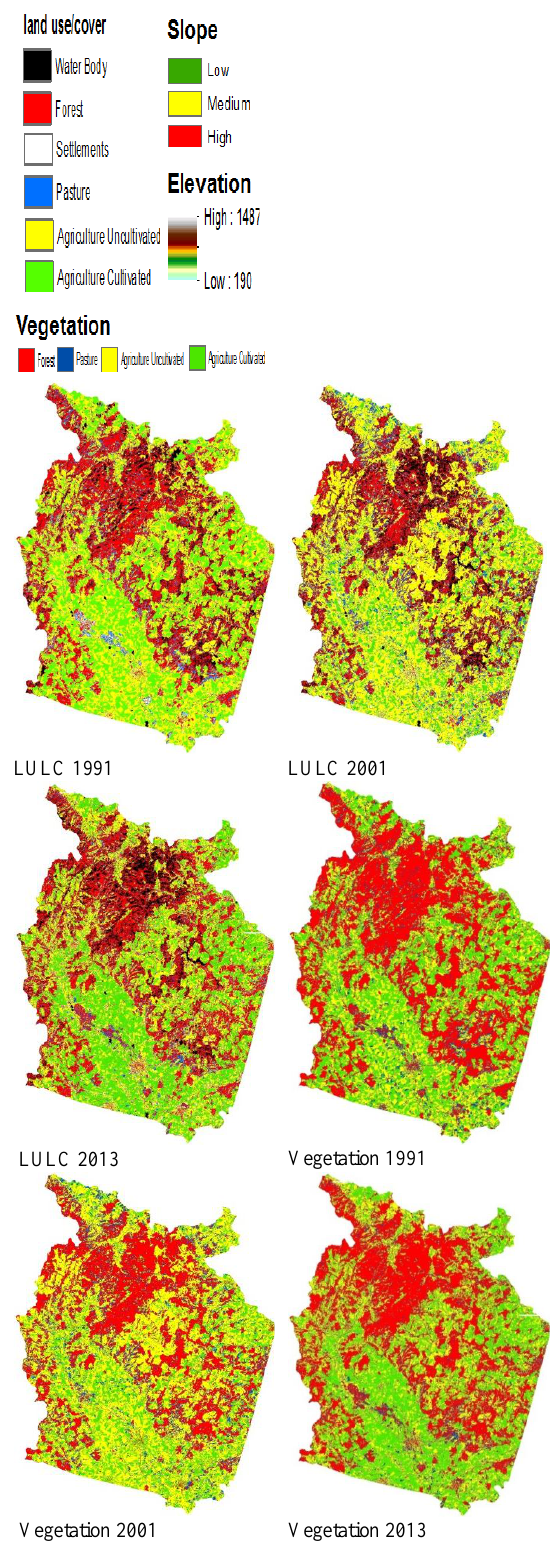
Figure 2. DEM, Slope, vegetation and land use/cover maps. After the standardization, SI and AI can be calculated based on Eq. (2), equal to the geometric mean of its standardized indicators. In this way the information of every indicator is contained by the target index, and each indicator is given the